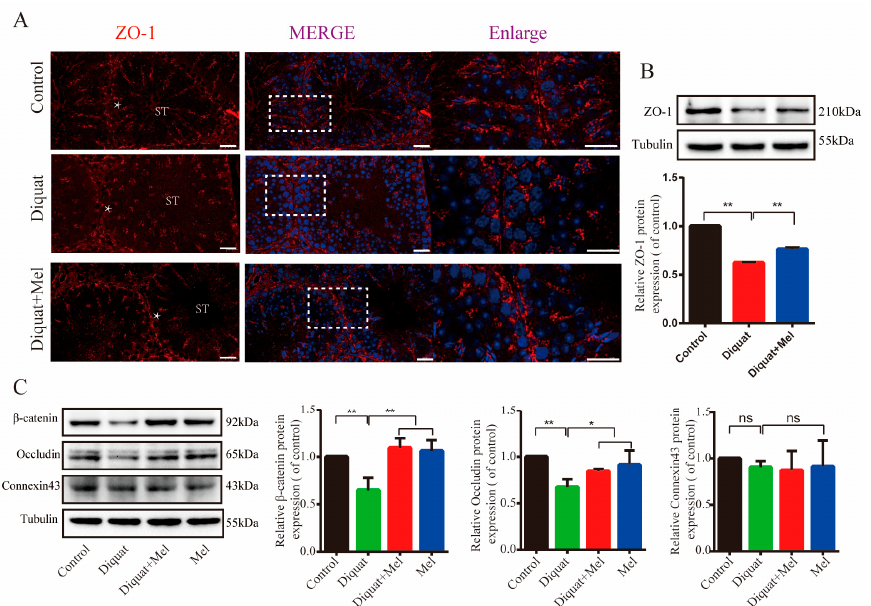
Figure 4. Melatonin restores the diquat-disrupted integrity of Sertoli cells: ( A ) representative immunofluorescence images showing the expression and localization of ZO-1 protein (The squares represent the enlarged position in the following figure); ( B ) relative expression of ZO1 using Western blotting in the control and diquat treatment with or without melatonin groups. Scale bars = 10 μ m; and ( C ) representative Western blotting and quantitative analysis of β -catenin, Occludin and Connexin43 in the different treatment groups. ST: seminiferous tubule. Asterisks indicate Sertoli cells. Data are presented as the mean ± SEM of at least three independent experiments. ns: not significant ( p ≥ 0.05 ) , * p < 0.05, ** p < 0.01.